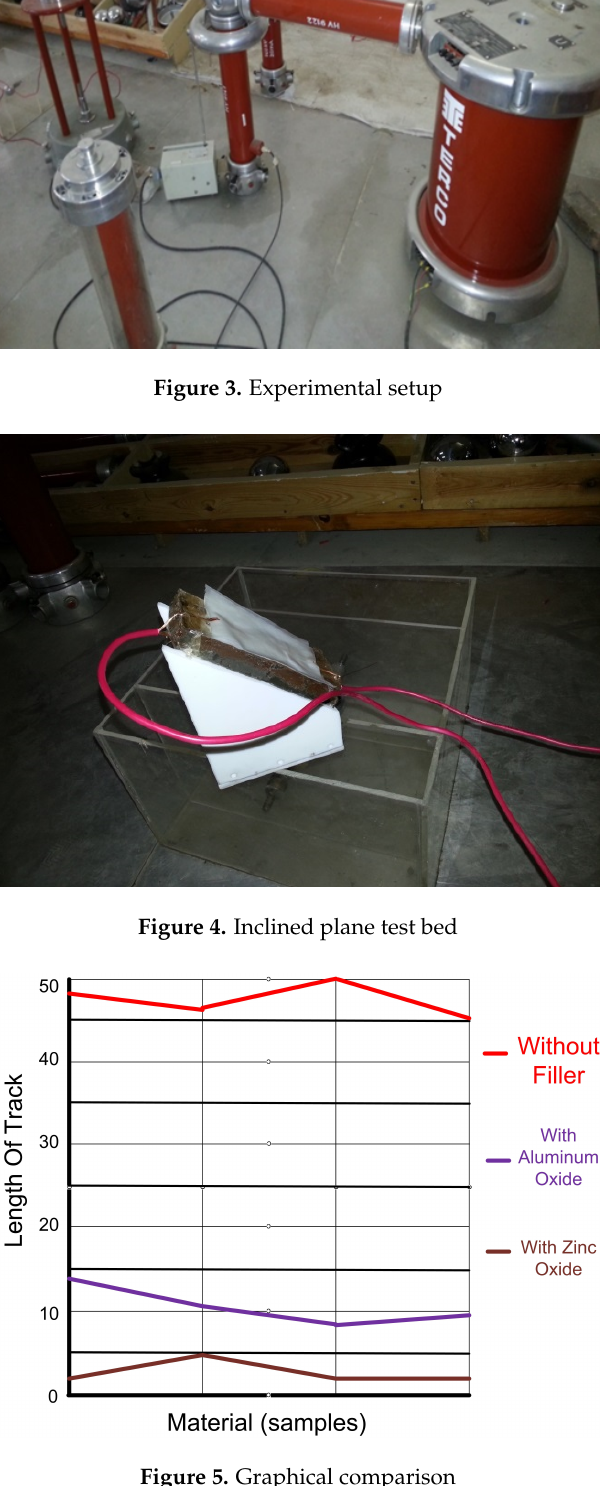
Figure 5. Graphical